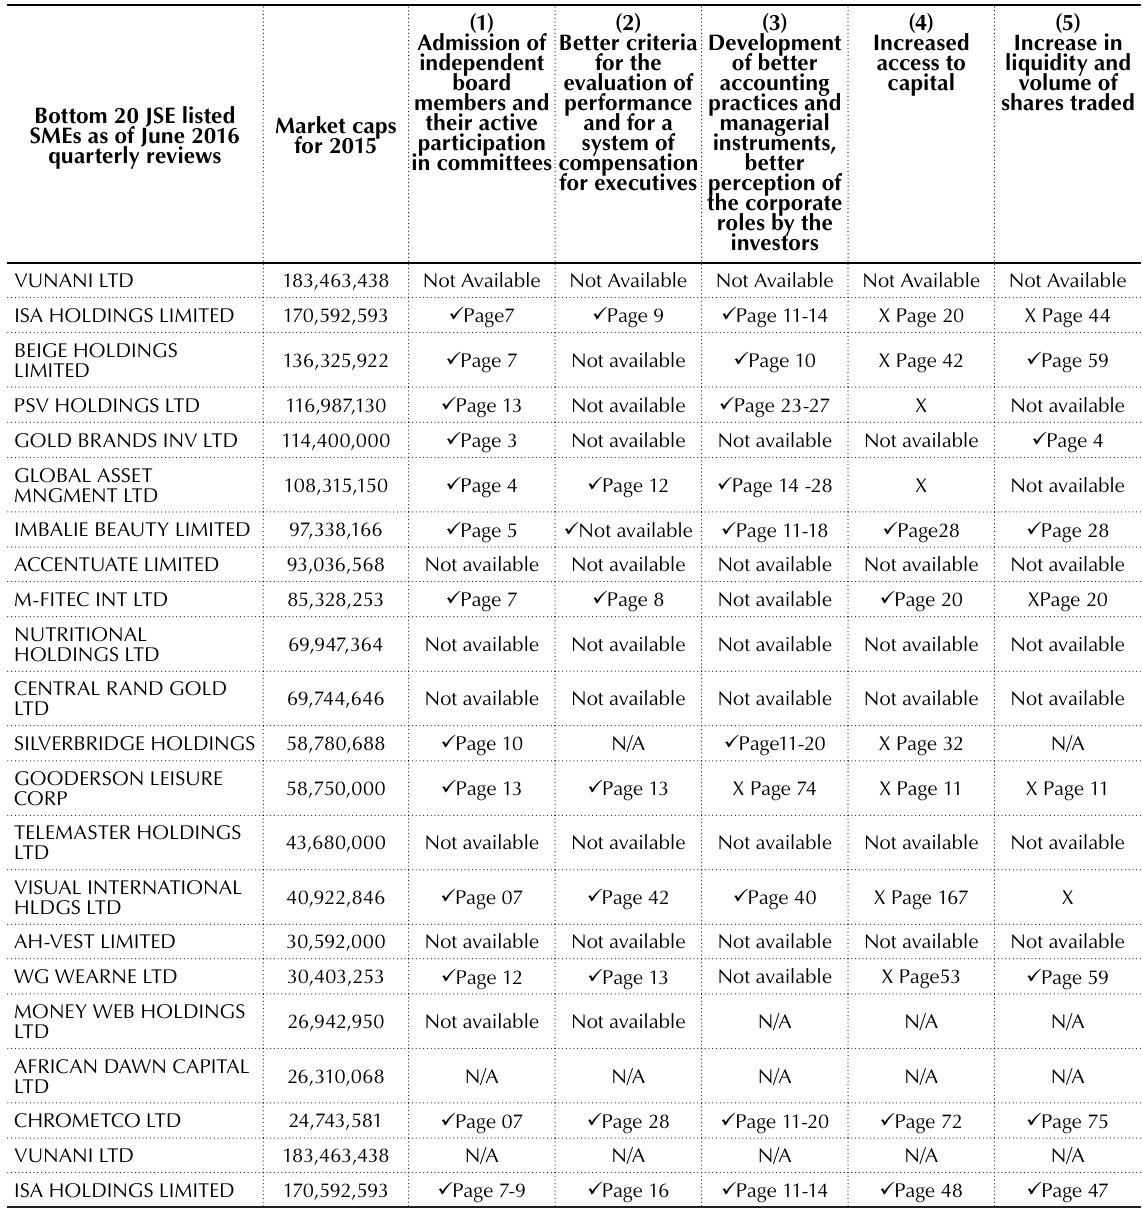
Bottom 20 JSE listed SMEs as of June